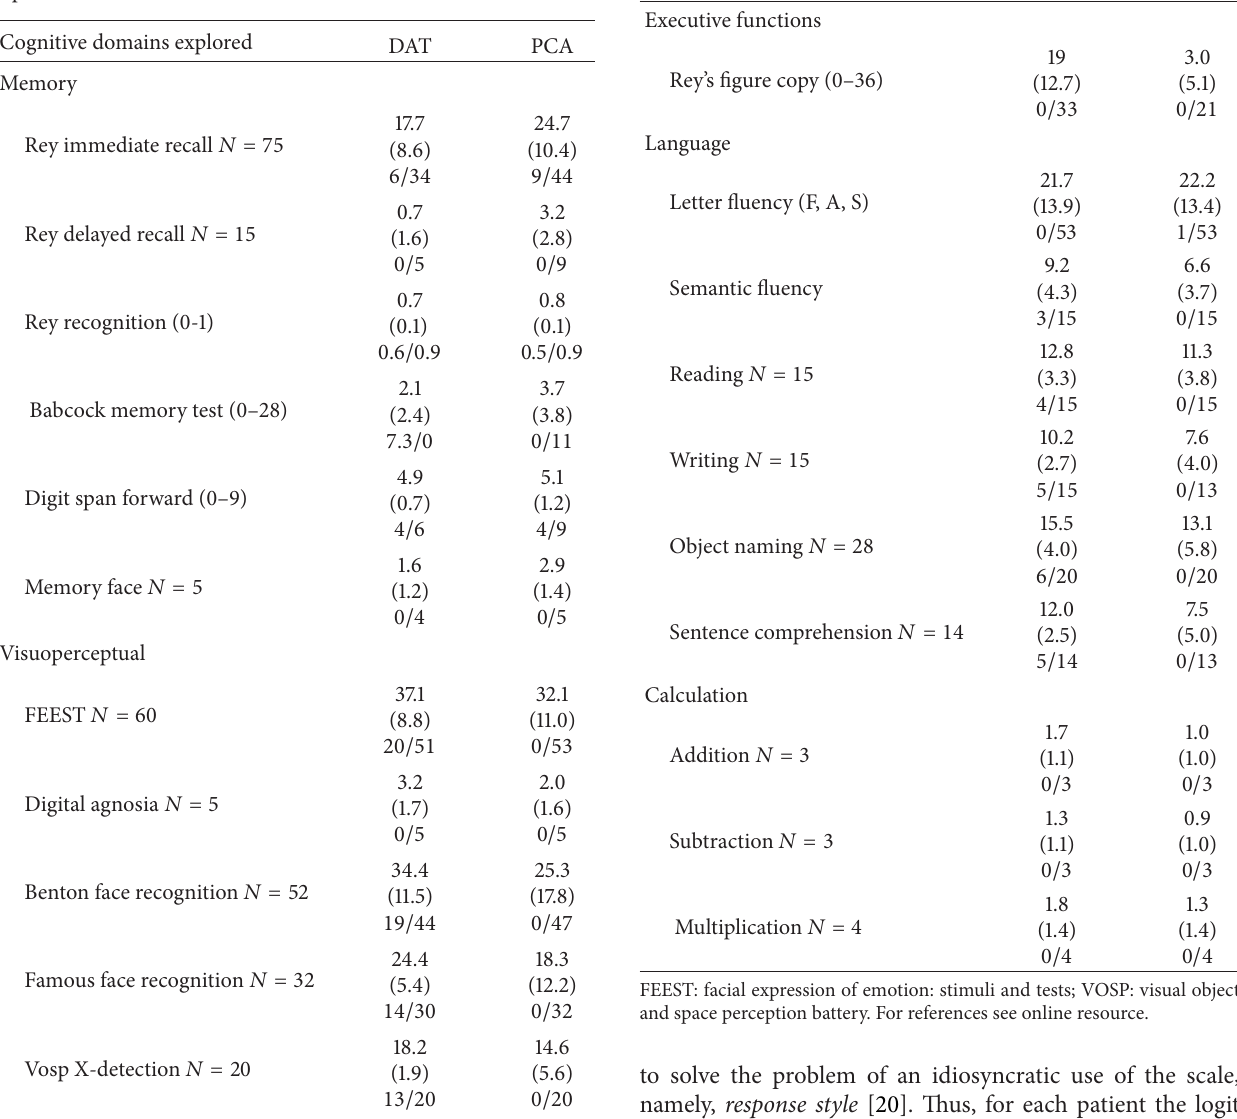
Table2:Variablesusedfortheprincipalcomponentanalysis.Means (sd) and ranges of the row scores obtained in DAT and PCA are